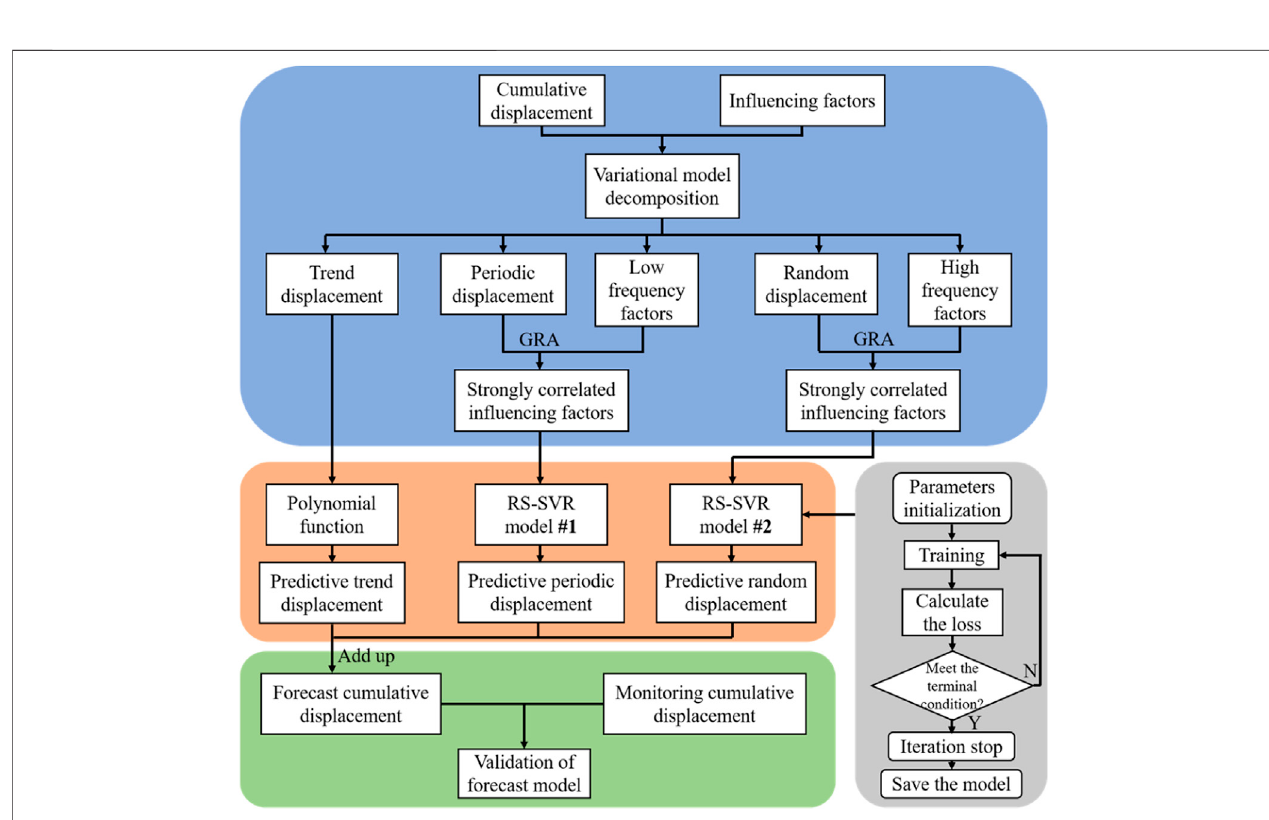
Frontiers in Earth Science |